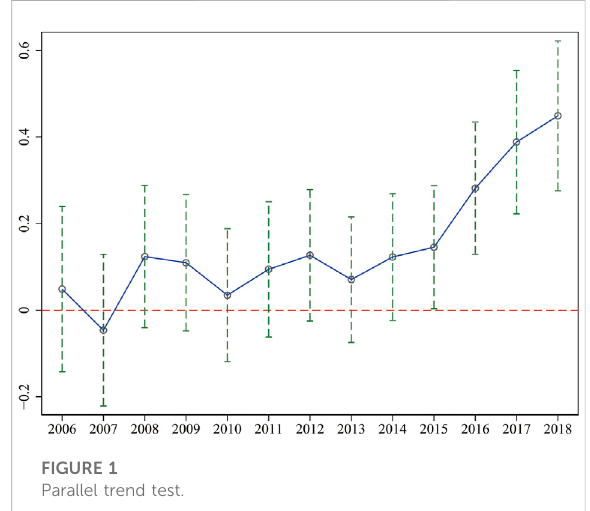
FIGURE 1 Parallel trend test.